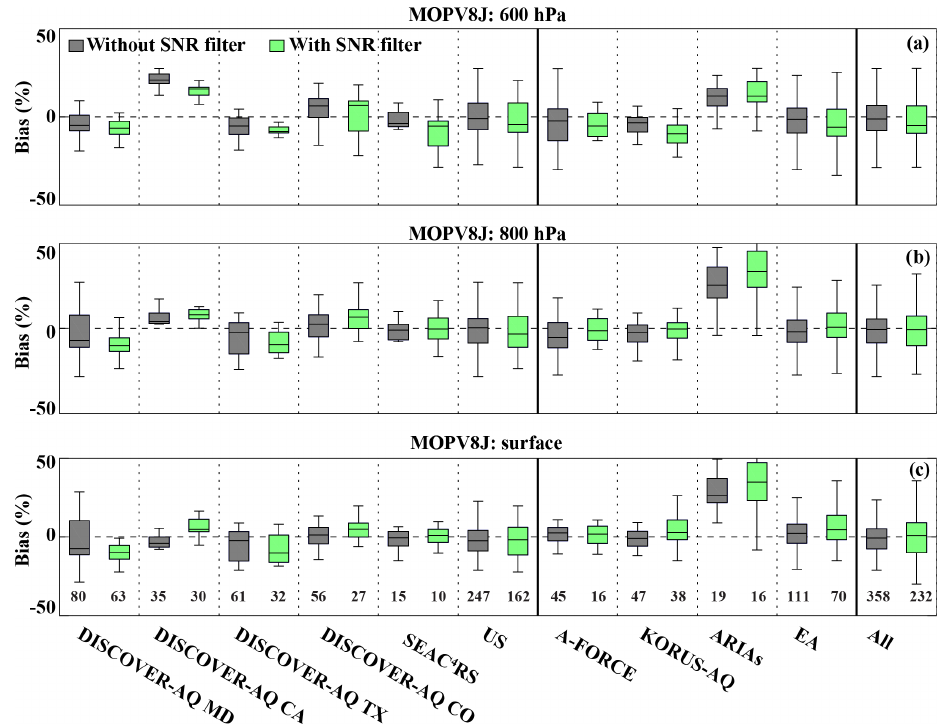
Figure 11. Sensitivity to the signal-to-noise ratio (SNR) filters. Biases (%) for MOPITT retrievals without SNR filters (gray) and MOPITT retrievals with SNR filters (green) at 600hPa layer (a) , 800hPa layer (b) , and the surface layer (c) are shown by box plot (with medians represented by middle bars, interquartile ranges between 25th and 75th percentiles represented by boxes, and the most extreme data points not considered outliers represented by whiskers). The numbers in (c) correspond to the number of in situ profiles qualified for validation without or with SNR filters. The biases are calculated against all (both urban and non-urban) in situ profiles listed in Table 1. The “without SNR filter” values (gray bars) in this figure are the same as yellow bars (for all data) in Fig. 6. See the caption of Fig. 6 for the definition of